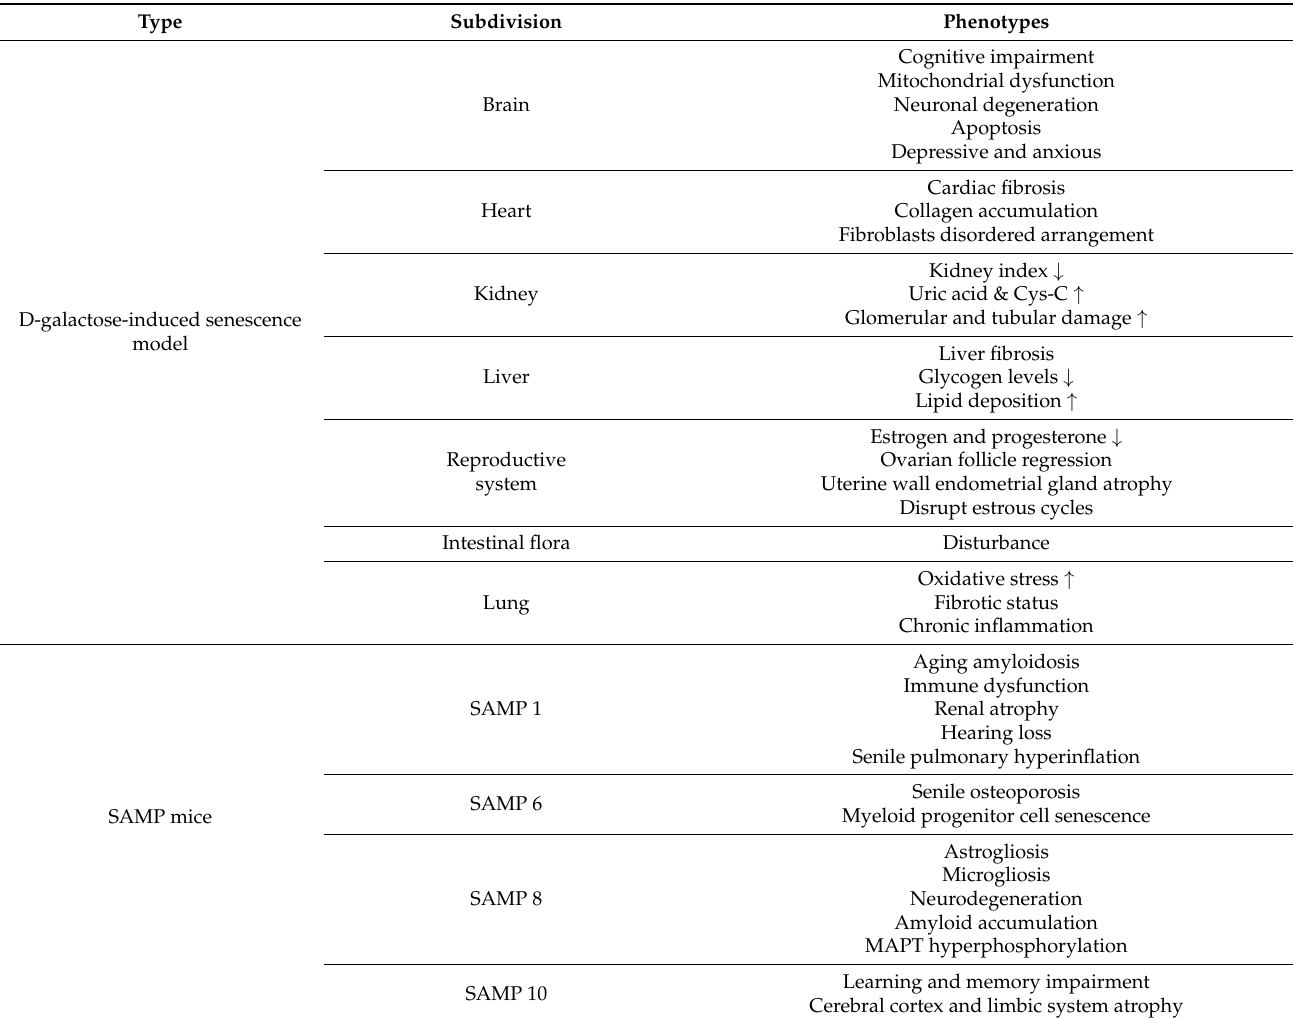
Table 1. Summary of systemic-induced accelerated aging mouse